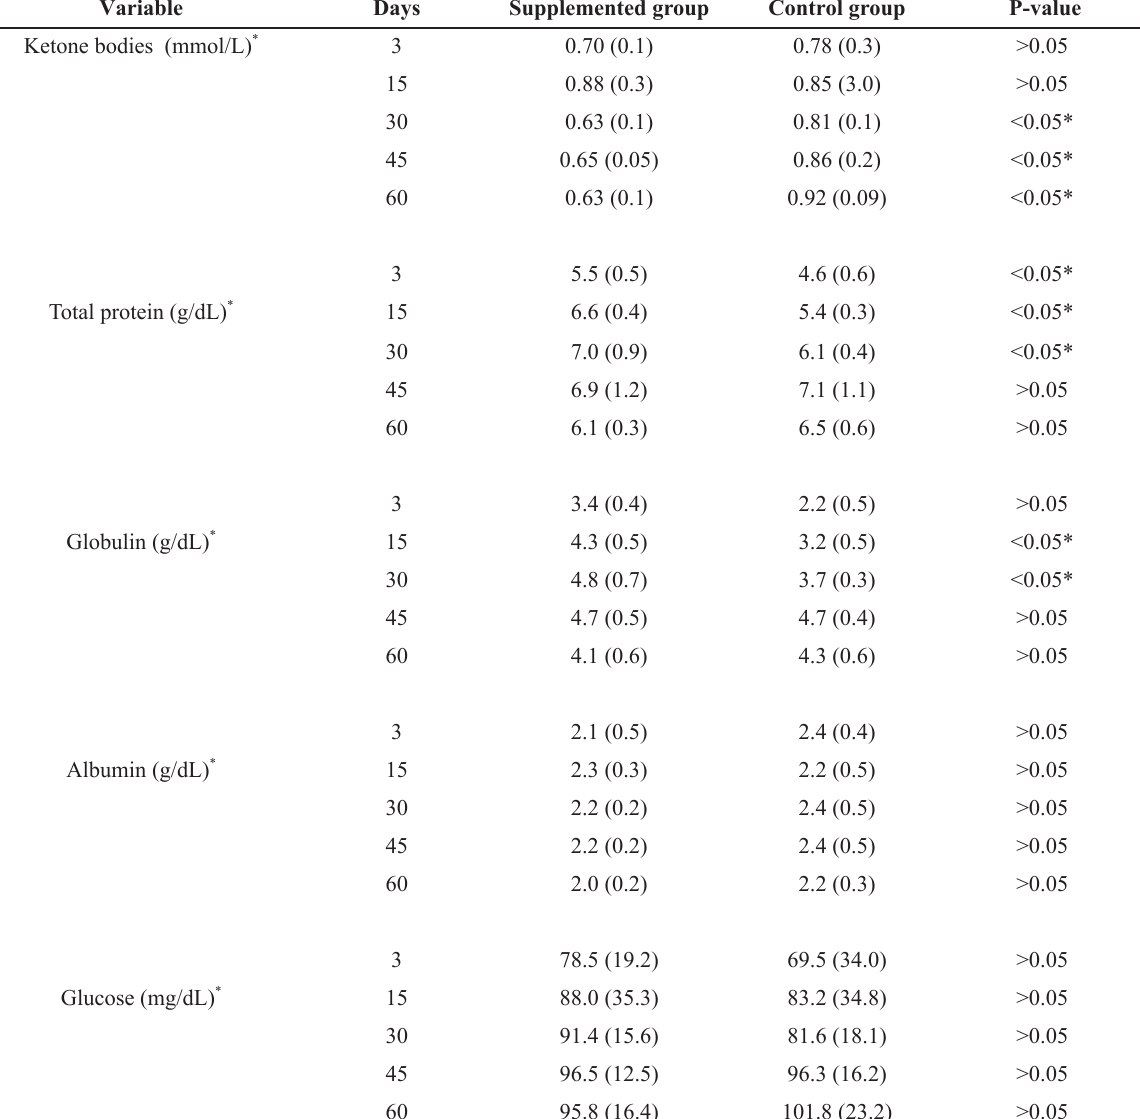
Mean and standard deviation of ketone bodies, total protein, albumin, globulin and glucose on days 3, 15, 30, 45 and 60 days post-calving of dairy primiparous cows supplemented with injectable minerals during the transitional period.